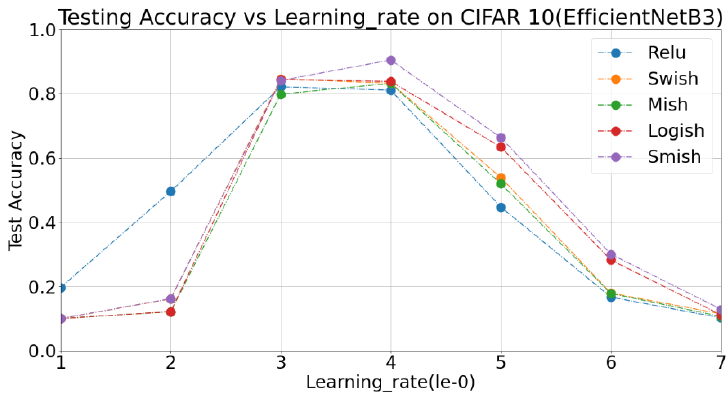
Figure 6. Training accuracy vs. learning_rate.